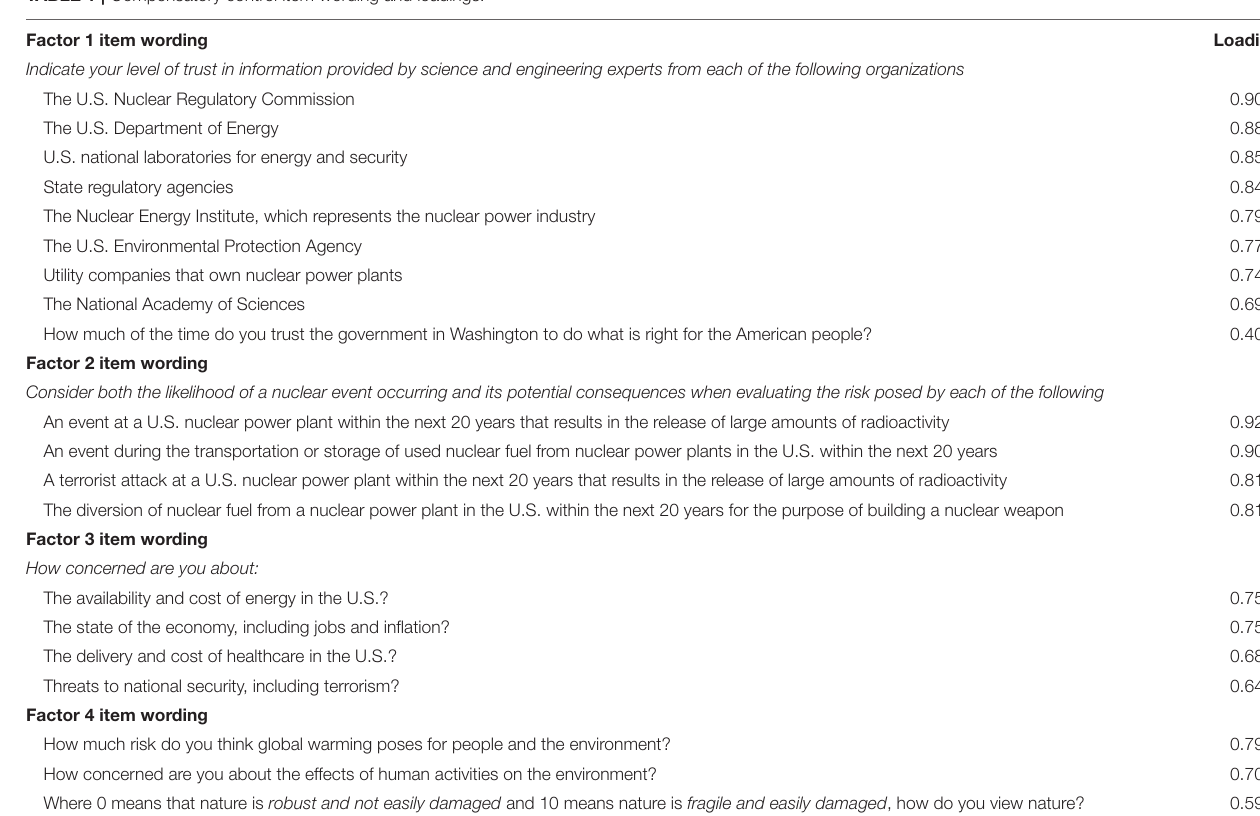
TABLE 1 | Compensatory control item wording and